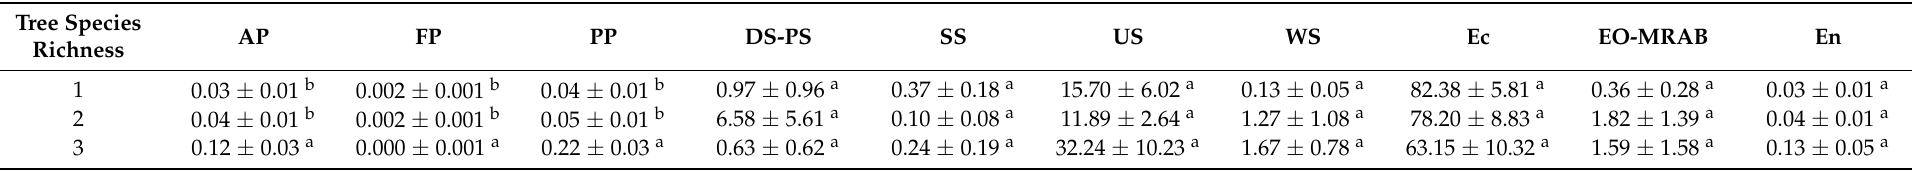
Table 1. The relative abundance (%) of Symbiotroph, Saprotroph and Pathotroph in soils of tree clusters varying in tree species richness, with one, two, and three tree species combinations. Tree